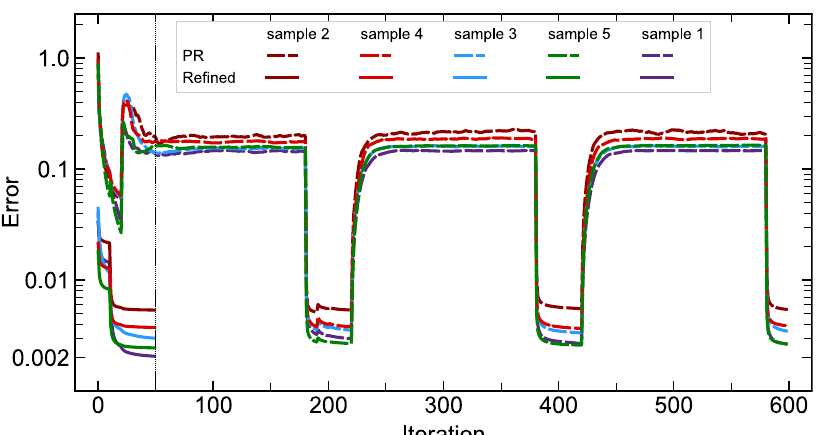
Fig. 4 Reconstruction error as a function of the iteration number for conventional phase retrieval and re fi nement. The dashed lines represent the error for conventional phase retrieval while the solid lines are for re fi nement